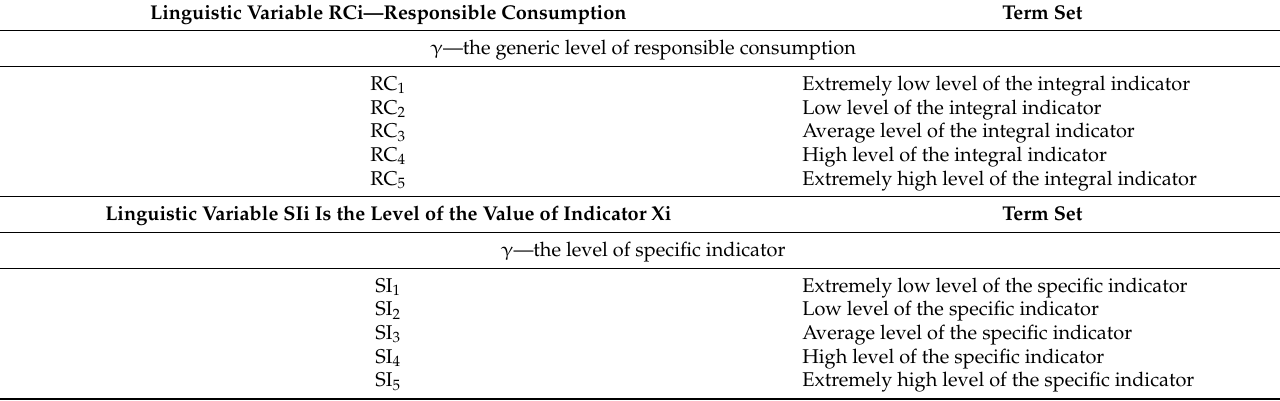
Table 35. Term-sets of linguistic